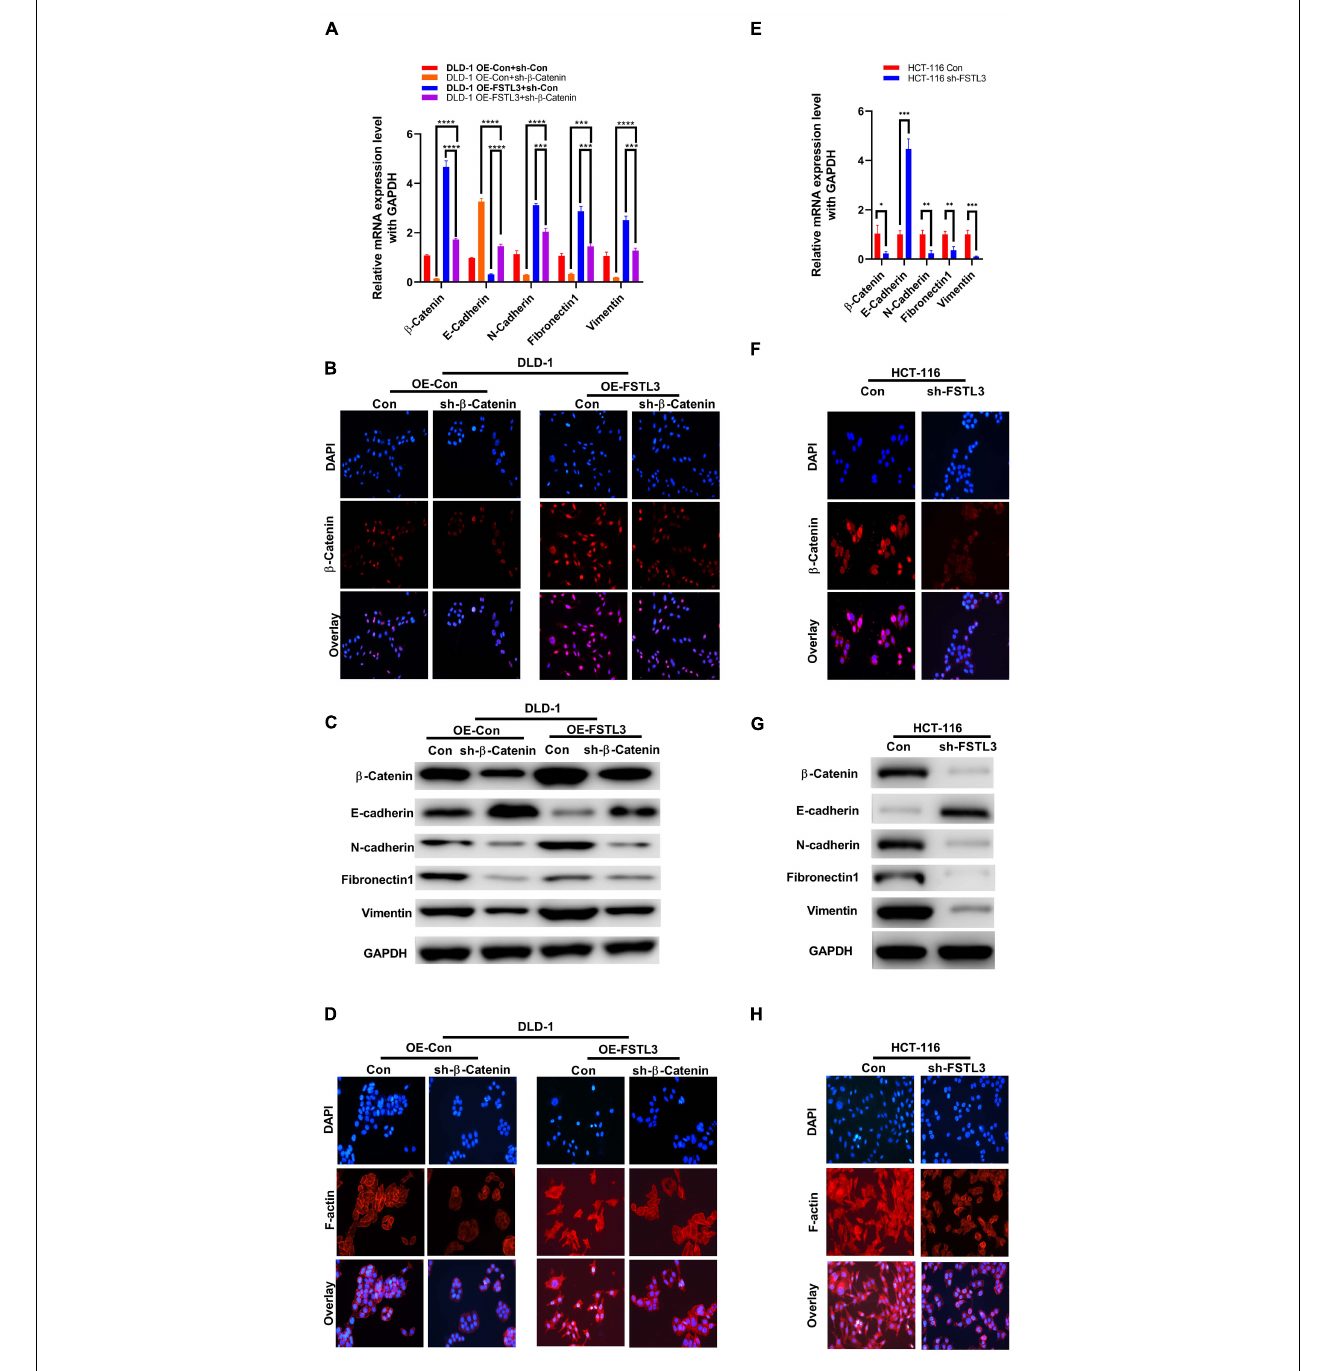
FIGURE 4 | FSTL3 induces β -Catenin-mediated EMT. (A) qRT-PCR displayed elevated β -Catenin mRNA expression in DLD-1 cells co-expressed with FSTL3. Impact of FSTL3 and β -Catenin expression on EMT in DLD-1 cells. **** p < 0.0001; *** p < 0.001. (B) Immunofluorescence of ectopically overexpressed FSTL3 promoted expression and nuclear translocation of β -Catenin, compared to control DLD-1 cells. (C) WB displayed increased β -Catenin protein expression in cells co-expressed with FSTL3. FSTL3 and β -Catenin expression is linked to the expression of EMT-related proteins in DLD-1cells. (D) Immunofluorescence showing that enforced FSTL3 expression increased F-actin levels. β -Catenin depletion decreased F-actin expression in DLD-1 cells, compared to control. (E) qRT-PCR displayed the impact of knock-down FSTL3 on β -Catenin and EMT-related genes in HCT-116 cells. *** p < 0.001; **p < 0.01; *p < 0.05. (F) Immunofluorescence of ectopically knock-down FSTL3 inhibited expression and nuclear translocation of β -Catenin, compared to control HCT-116 cells. (G) WB displayed FSTL3 expression is linked to the expression of β -Catenin and EMT-related proteins in HCT-116 cells. (H) Immunofluorescence showing that FSTL3 depletion decreased F-actin expression in HCT-116 cells, compared to